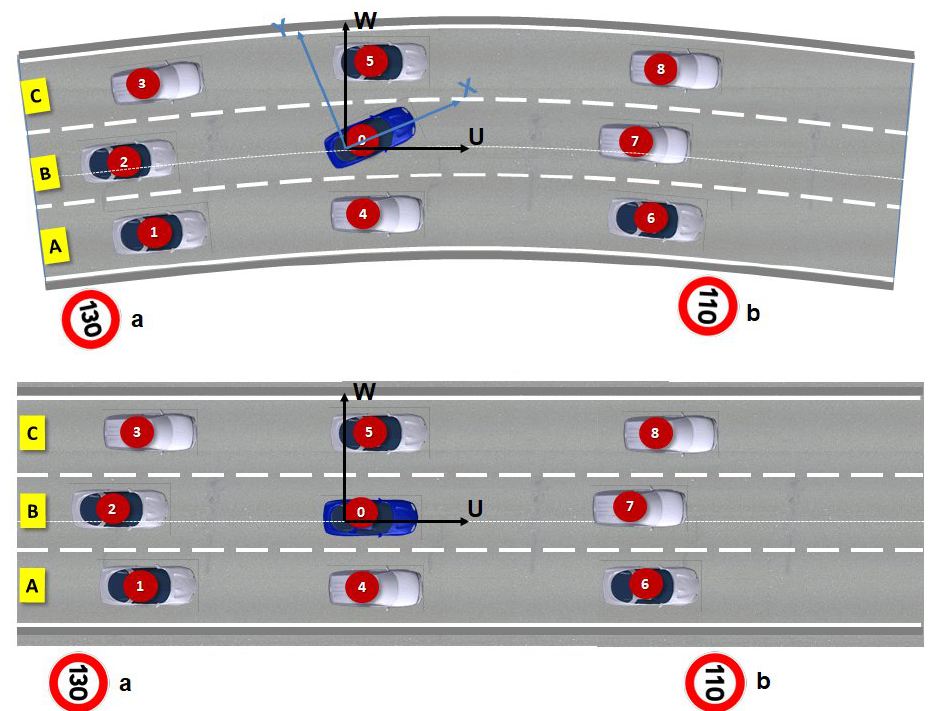
Figure A1. Perception of the environment (ego-vehicle, obstacles, traffic lanes and road markings) and passage of the real perception reference XY in the virtual path planning reference